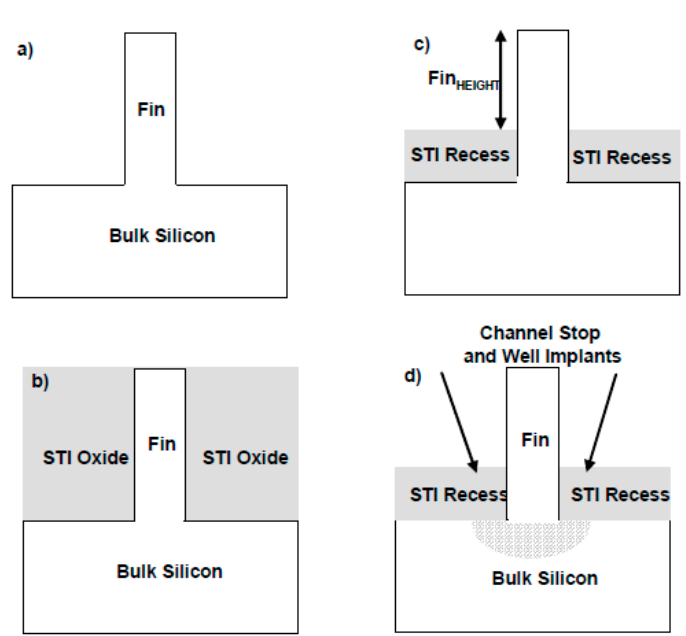
Figure 17. A schematic of STI process of Si fins with ( a ) Si fins formation; ( b ) STI oxide filled in; ( c ) STI oxide recess and ( d ) channel stop and well implants. Reproduced with permission from [129]. Copyright Springer, 2008.